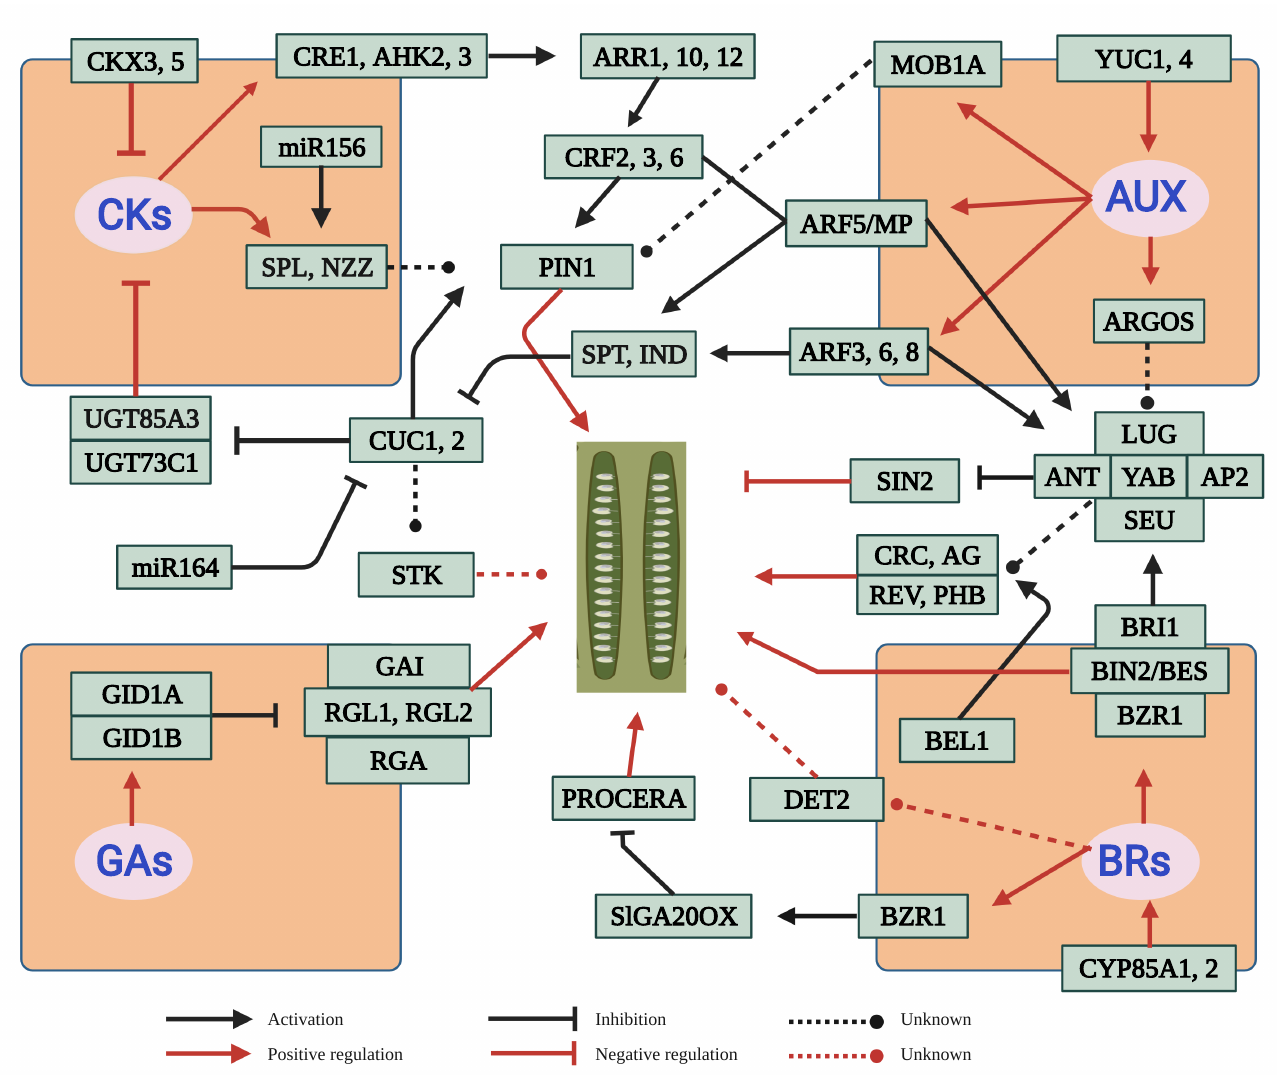
Figure 2. An integrated gene network for the regulation of ovule number. Four types of phytohormones (AUX, BRs, CKs and GAs) and other regulators are shown in blue and black color, respectively. The black and red arrows show the relationship between the up-/down-stream genes and between genes and phenotype,